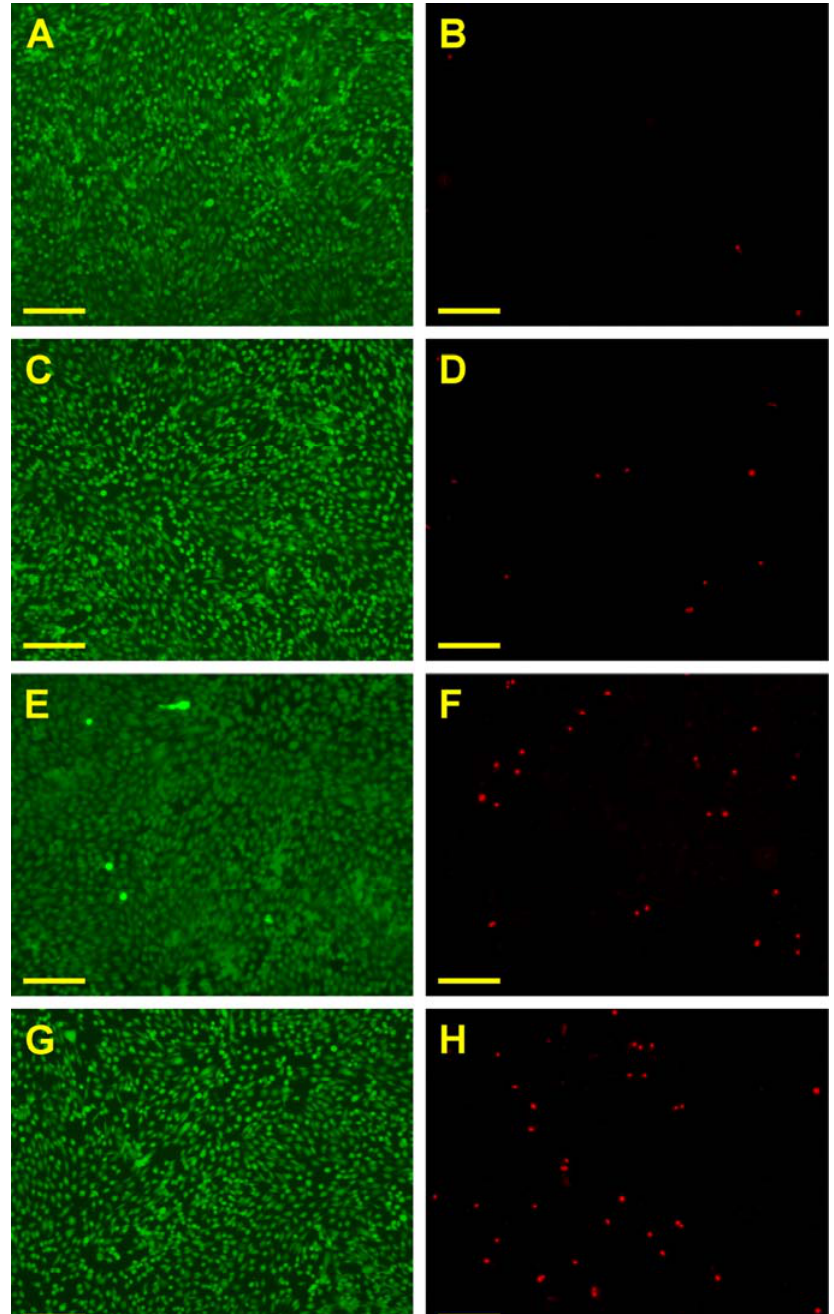
Figure 3. Cell viability of ARPE-19 cultures was determined by staining with Live/Dead Viability/Cytotoxicity Kit in which the live cells fluoresce green and the dead cells fluoresce